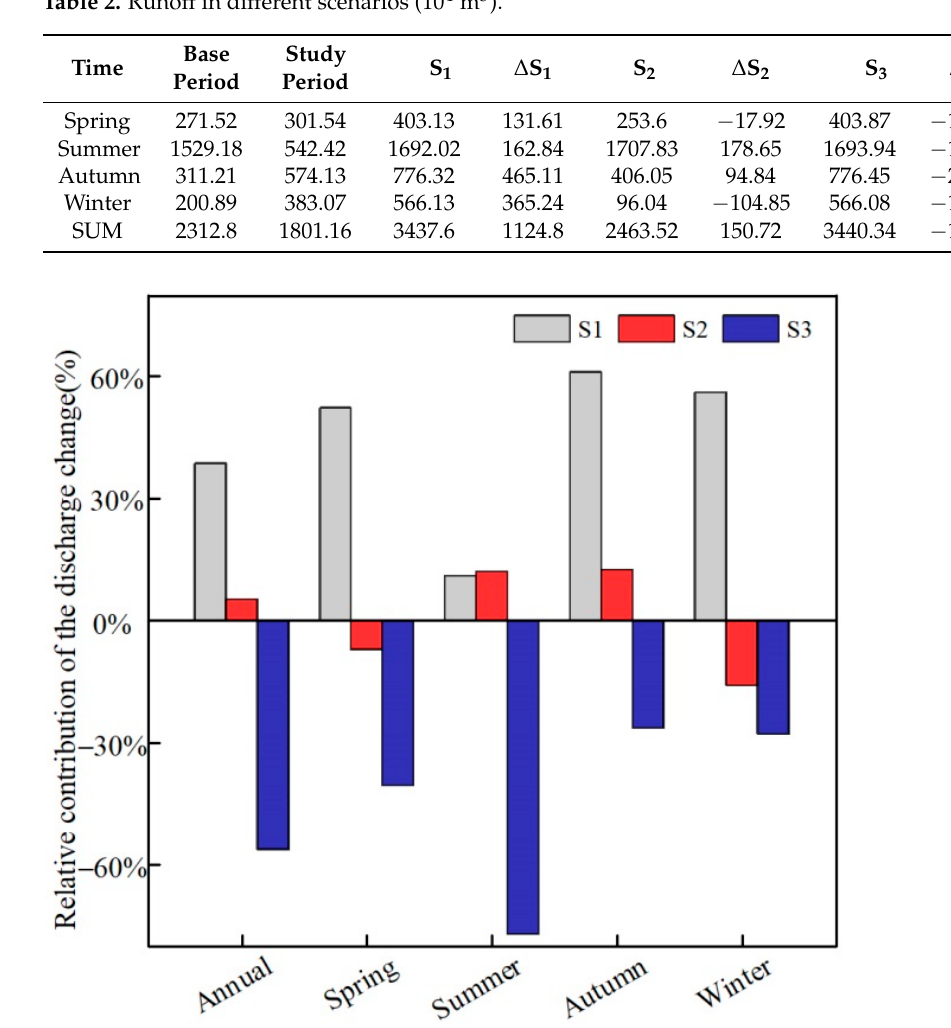
Figure 4. Contributions of climate, land use and human activity to discharge change on the annual and seasonal scale in the three scenarios